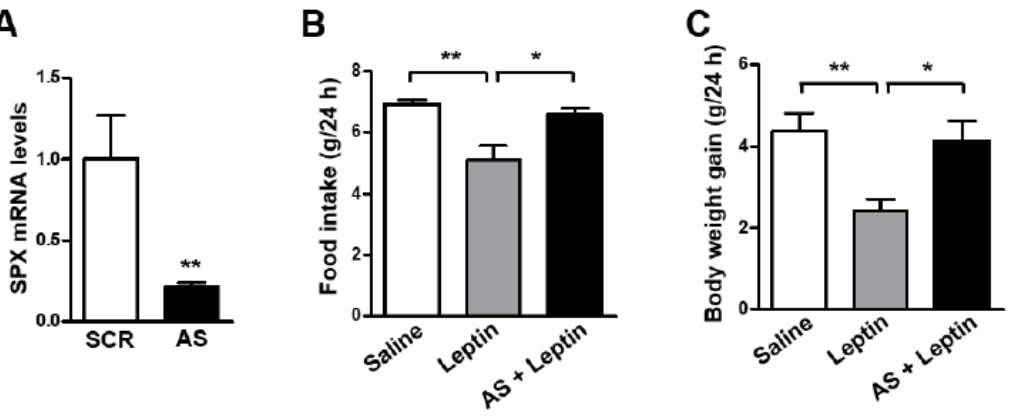
Figure 3. Effect of SPX synthesis blockade on the anorexigenic effects of leptin. To inhibit SPX synthesis in the brain, eight-week-old male mice were icv-injected with 2 µ g of antisense (AS) or scrambled (SCR) oligodeoxynucleotide (ODN) once a day for 2 days. ( A ) MBH samples were collected at 24 h after the second ODN injection and SPX mRNA levels were determined using qRT-PCR. ( B , C ) Mice injected twice with AS ODN were fasted for 24 h before icv leptin (2.5 µ g) injection. Food intake ( B ) and body weight gain ( C ) were measured for 24 h after leptin injection. Data are presented as mean ± S.E.M. *, p < 0.05; **, p <